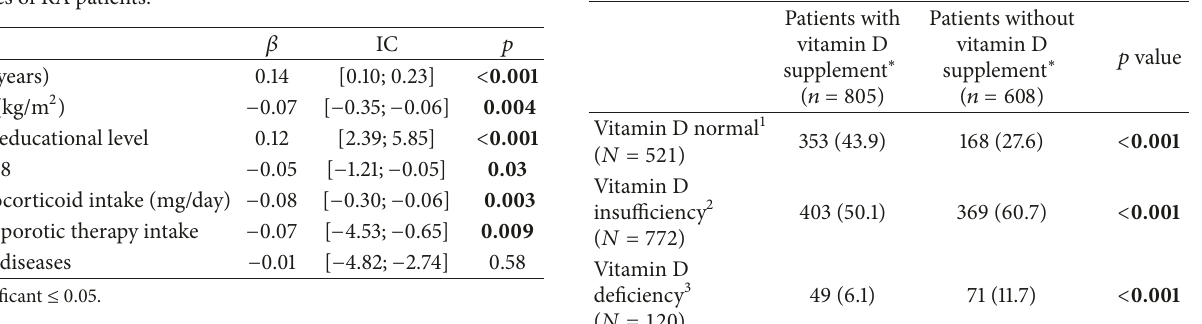
Table 7: Vitamin D status according to vitamin D